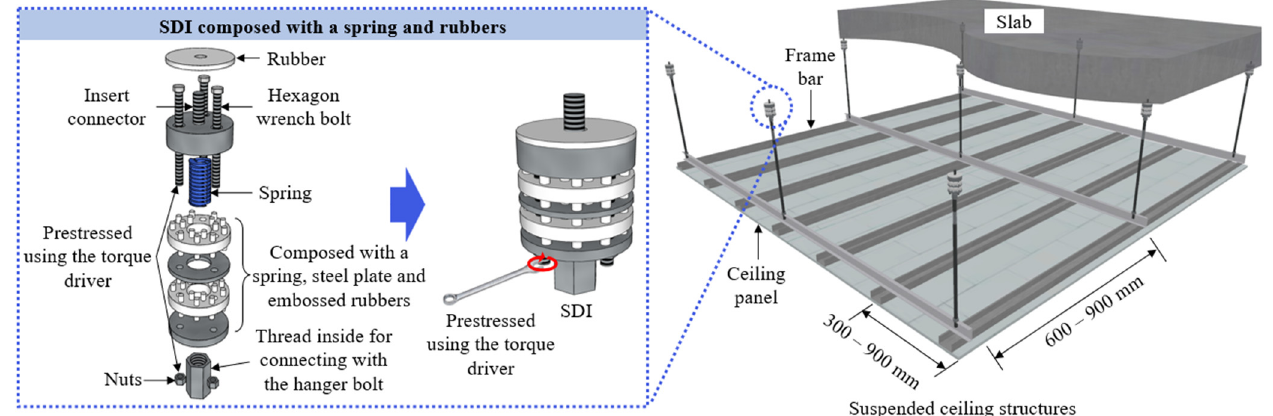
Figure 1. Details of the SDI for enhancing the seismic resistance of suspended ceiling structures.